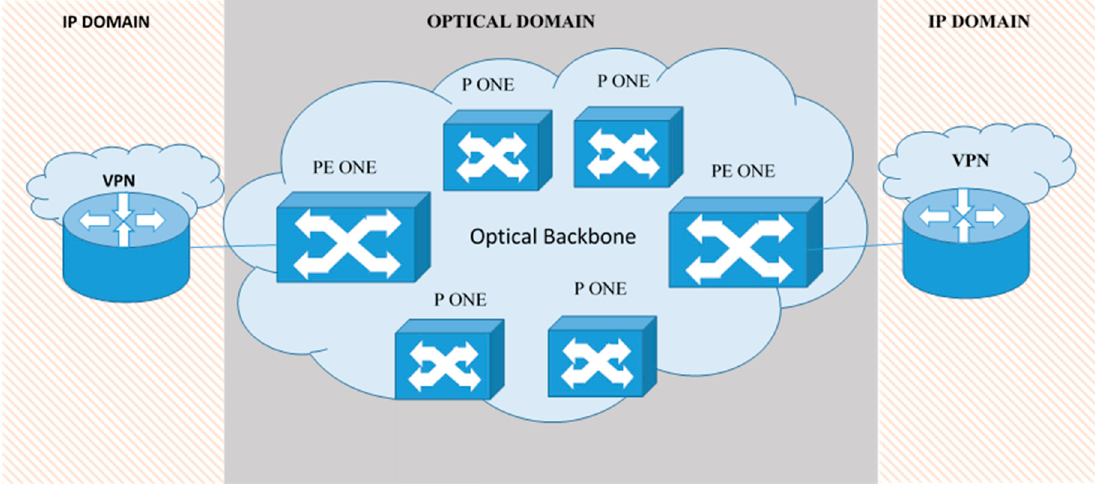
Figure 1. Virtual private network (VPN) over optical network multilayer model .